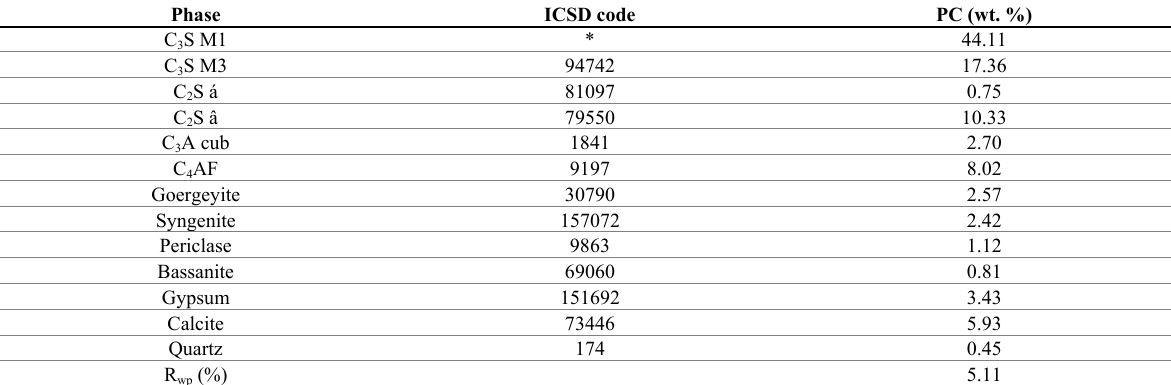
Table 2. Mineralogical composition of the cement used obtained by XRD-Rietveld